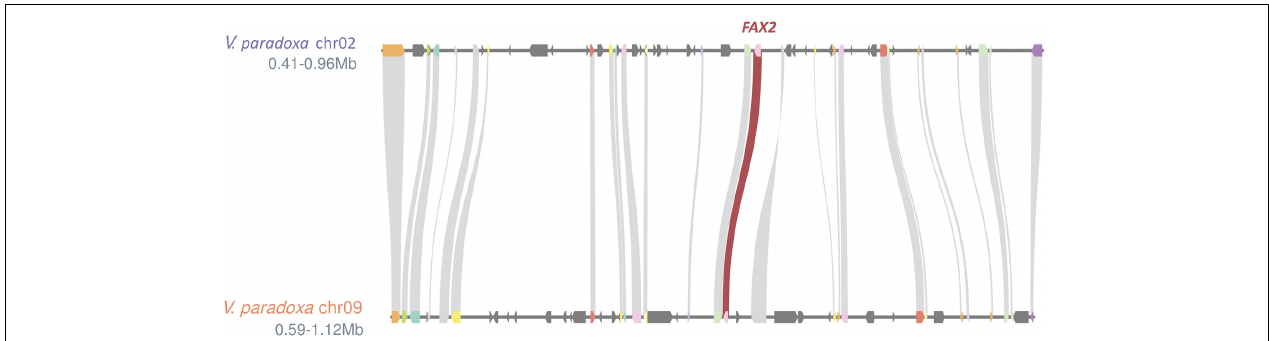
FIGURE 6 | Microsynteny plot showing ∼ 0.5 Mb regions exhibiting strong synteny (26 gene models) between shea Chromosomes 2 and 9. The existence the two copies of FAX2 within these larger syntenic neighborhoods suggests that shea’s relatively high copy number of this FA biosynthesis gene likely can be traced to a large-scale duplication event like WGD. Microsynteny plots for FATB , FAD2 , FAD3 , and (as counterpoint) KASIII can be found in Additional File 1: Supplementary Figures 4–7